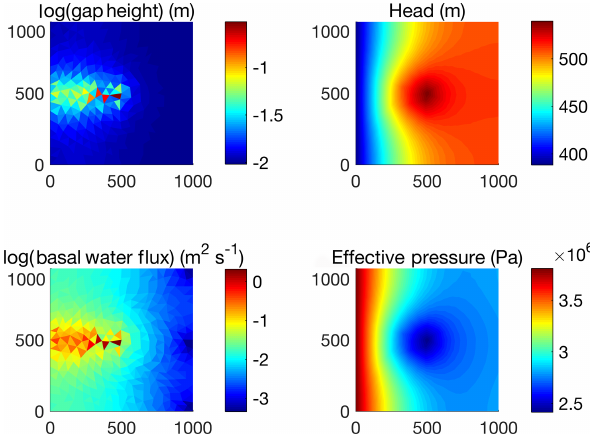
Figure 4. Snapshots of dynamic subglacial hydrology fields on day 23 in IDC1 using the SUH routing method to drive moulin input (see full animation of channel evolution and fluctuation in the Sup- plement). An efficient channelized drainage pathway develops from the moulin location at the center of the domain to the outflow at the left, characterized by higher gap height, water flux, effective pres- sure, and lower hydraulic head than its surroundings perpendicular to